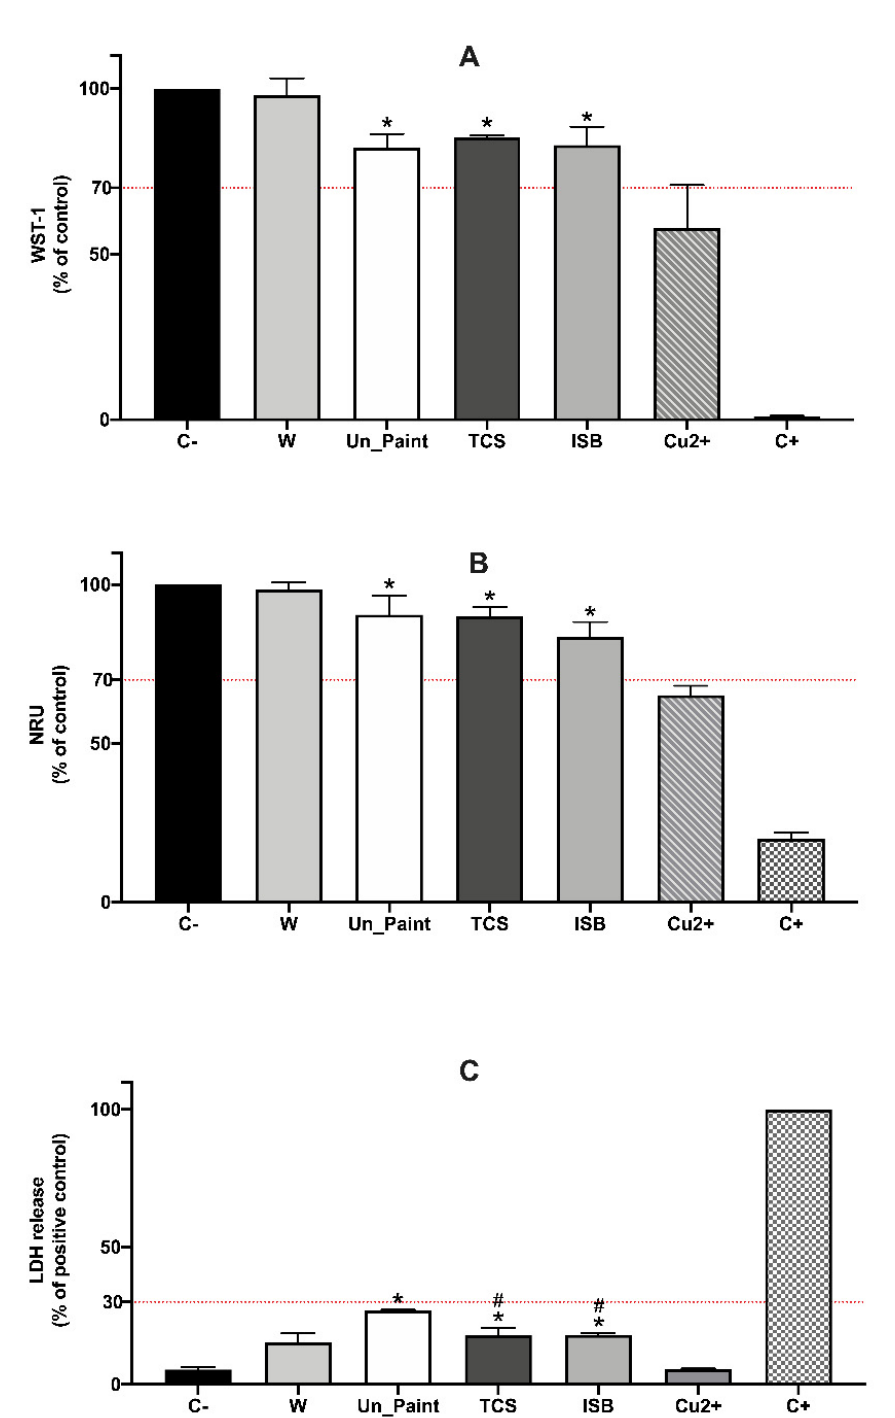
Figure 3. Results of WST-1 ( A ), NRU ( B ) and LDH ( C ) assays, with HaCaT cells, after 24 h of direct contact with the samples (in the x axis) of unmodified paint (Un_Paint), triclosan (TCS), isoborneol (ISB), transparent polymeric film (W) and Copper (Cu 2+ ). C-negative control (assay medium), C+ positive control (Triton X-100 solution (1%) for WST-1 and LDH or SLS 0.2 mg/mL for NRU). The red lines represent the defined thresholds of acceptable values for each parameter, 70% for cellular viability and 30% for LDH leakage. The values are expressed as mean ± standard deviation. The statistical significance of samples compared to C- is represented by * and the statistical differences compared to Un_Paint are represented by # (One-way ANOVA; p < 0.05).